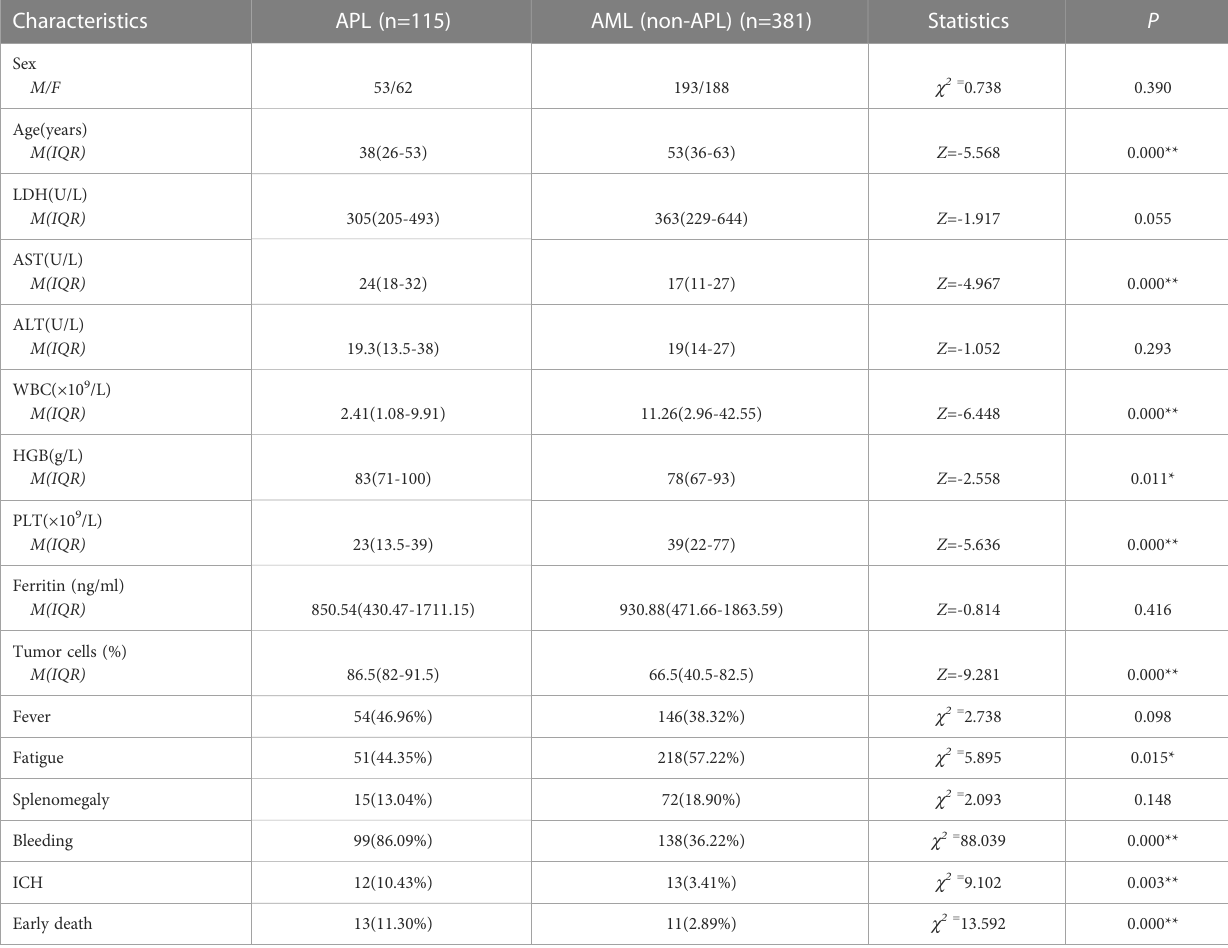
TABLE 1 Comparison of clinical characteristics between newly diagnosed APL and AML (non-APL) patients.